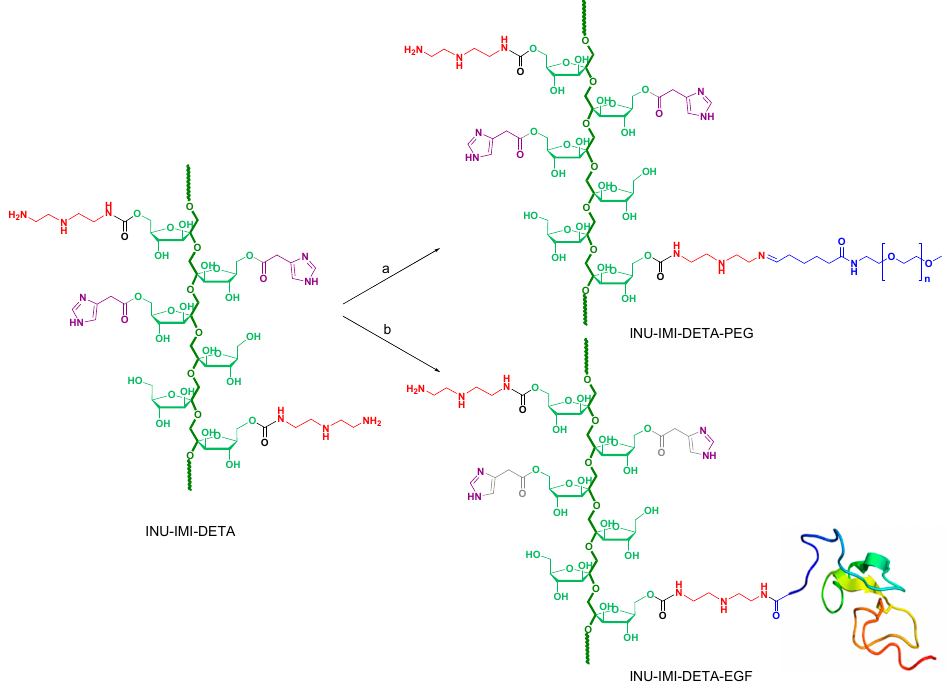
Figure 1. Schematic representation of INU-IMI-DETA-EGF synthesis. ( a ) PEG 2000 CHO, water, pH5, r.t. overnight; ( b ) EDCI, NHS, hEGF, water, r.t. 6 h.